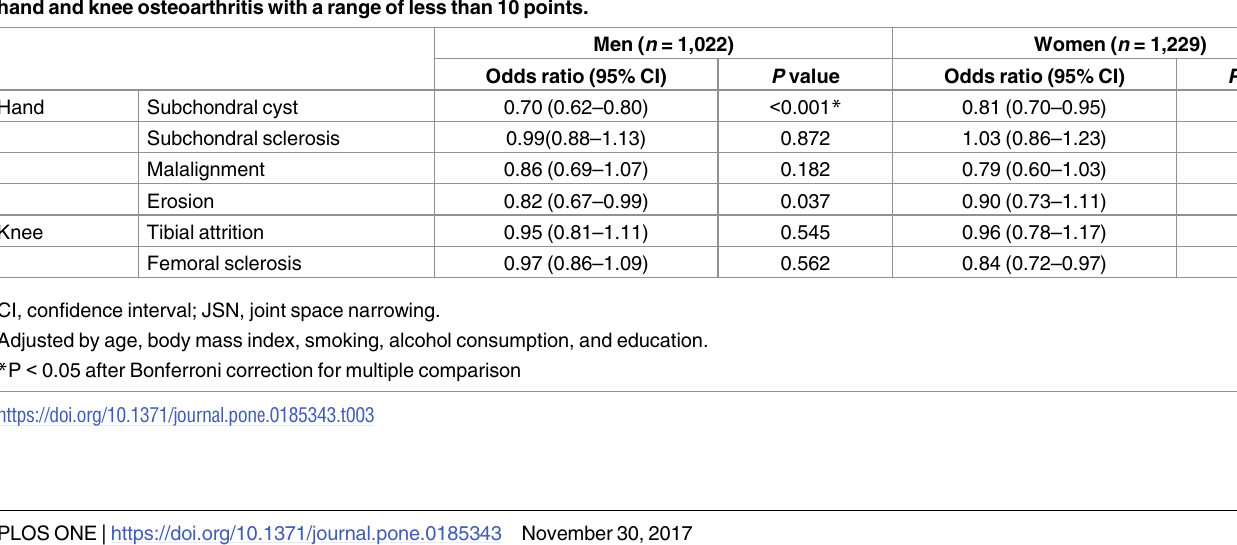
Table 3. Odds ratios from a logistic regression model examining the association of grip strength (5 kg) for with individual radiographic featuresof hand and knee osteoarthritis with a range of less than 10 points.